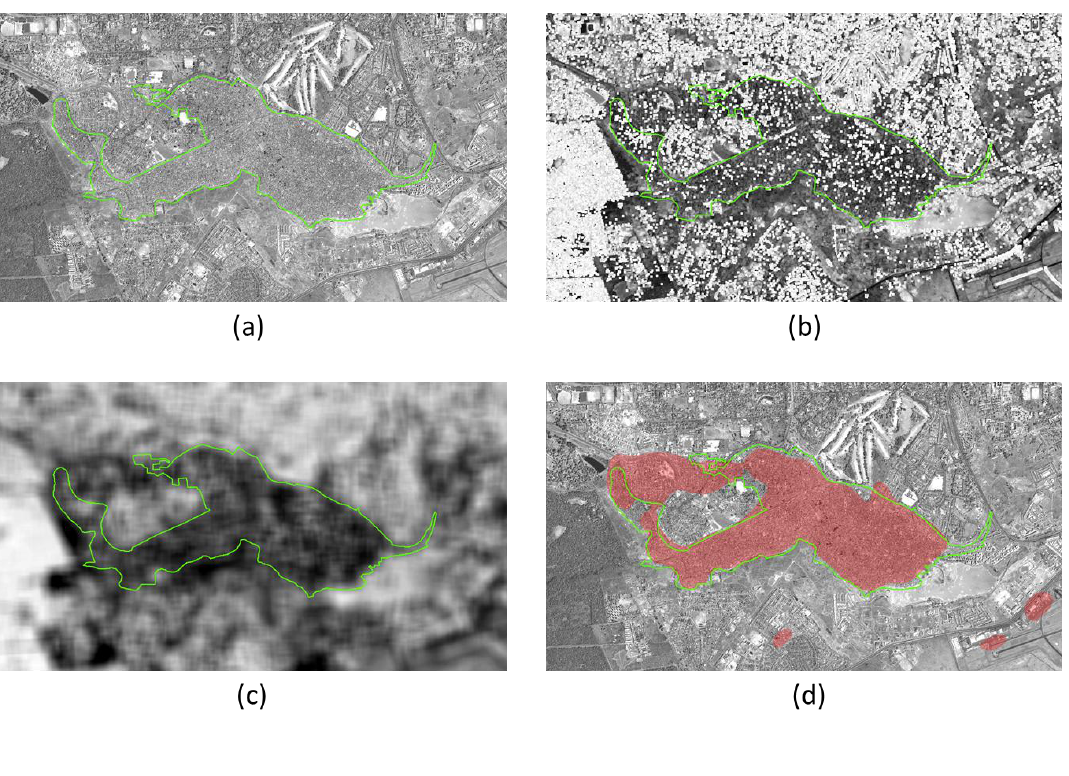
Figure 7. Results of the proposed procedure applied to the Kibera slum: ( a ) Quickbird panchromatic image, with superimposed the UN-Habitat layer; ( b ) output of the morphological opening filter; ( c ) output of the low-pass filter applied to the previous result; ( d ) final results, to be compared with the actual Kibera extents, in